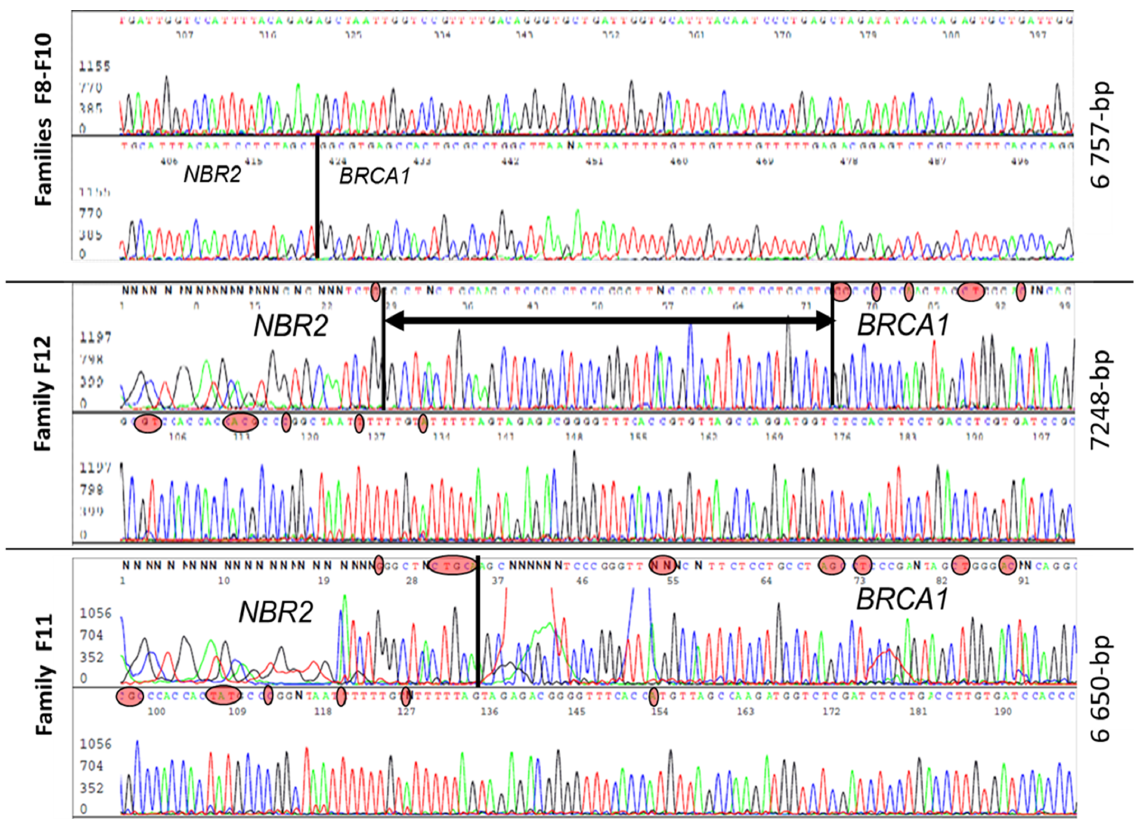
Figure 4. Sanger sequences analysis of three different 5–10 kb deletions with very close breakpoints harbored by individuals from five unrelated families. In red circles are nucleotides specific to the BRCA1 and NBR2 genes. The black vertical line is the breakpoint position and the horizontal line with arrows is a common region in which there is a breakpoint.